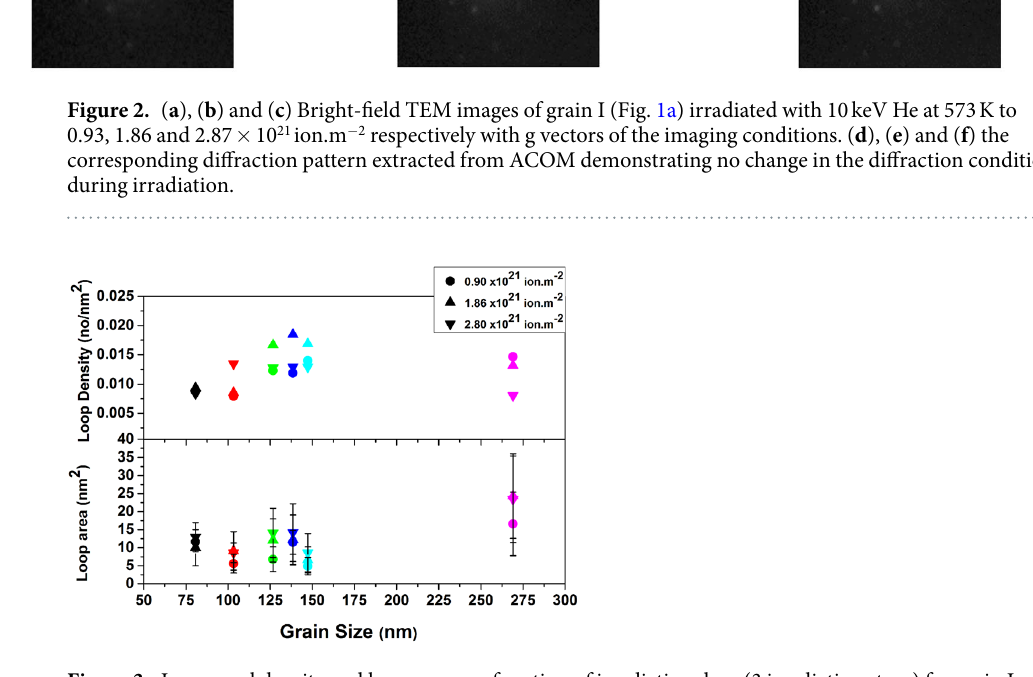
Figure 3. Loop areal density and loop area as a function of irradiation dose (3 irradiation steps) for grain I through VI (in Fig. 1a) as being irradiated with 10 kev He at 573 K. Diffraction conditions remained the same during irradiation. Error bars in the density graphs are smaller than the